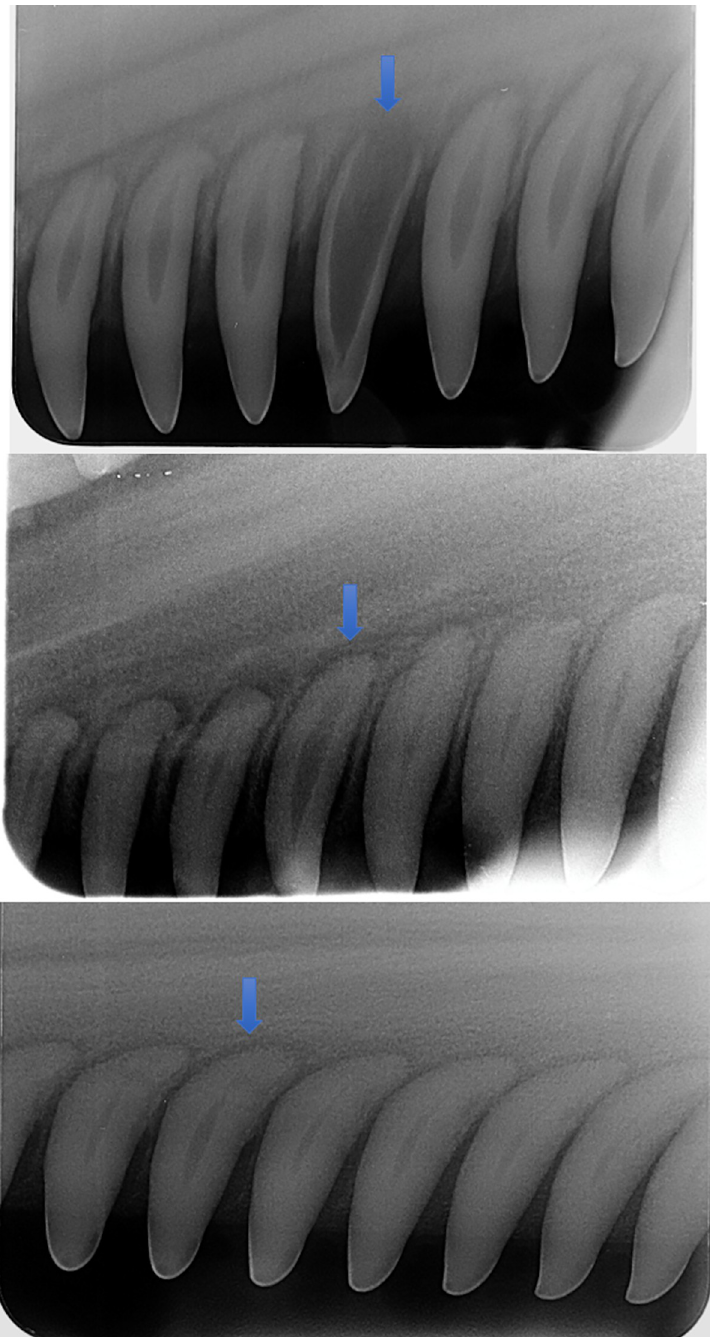
Fig 4. Examples of non-vital teeth. Each radiograph typically captured five to seven teeth, allowing analysts to identify and exclude non-vital (dead) teeth (blue arrows) from the pulp and tooth area calculations, as these teeth no longer accumulate dentin layers as the dolphins